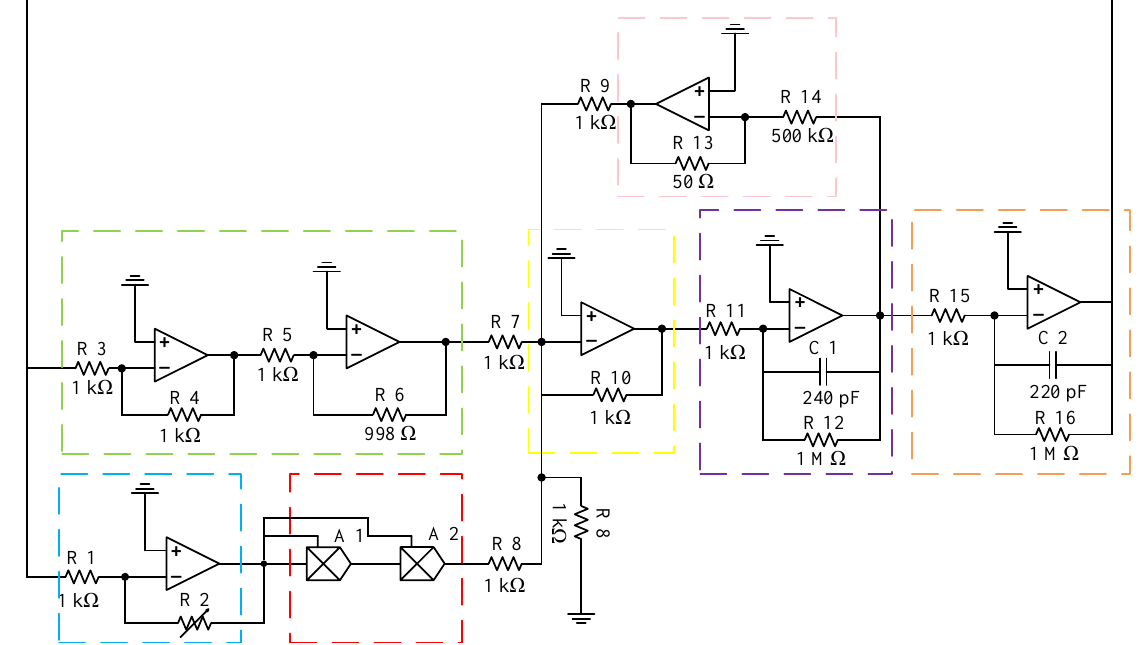
Figure 12. Circuit principle diagram of resonant beam with comb fingers.